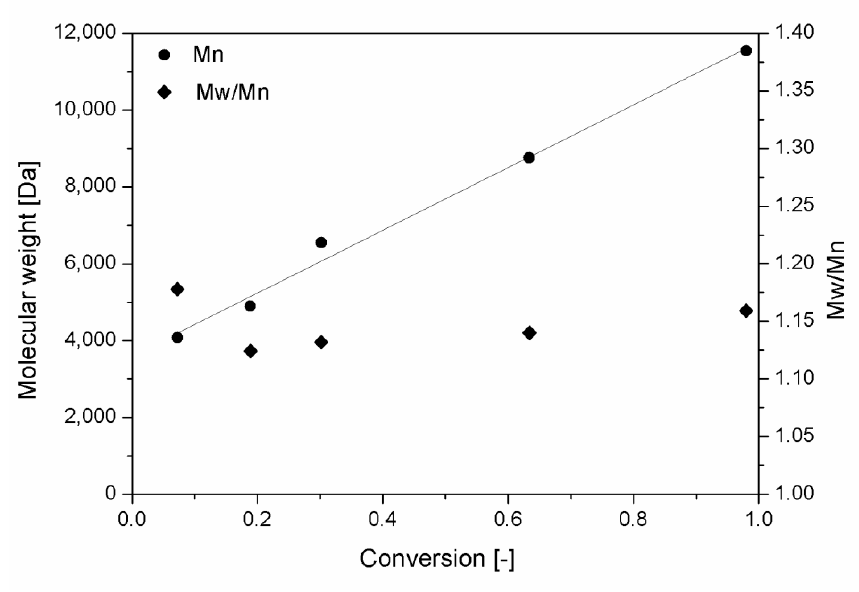
Figure 2. RAFT polymerization of 20CL 3 . Molar mass and molar mass dispersity as a function of the macromonomer conversion. Table 1. Characterizations for the first class ( m CL n ) and second class ( m CL n PEG) of